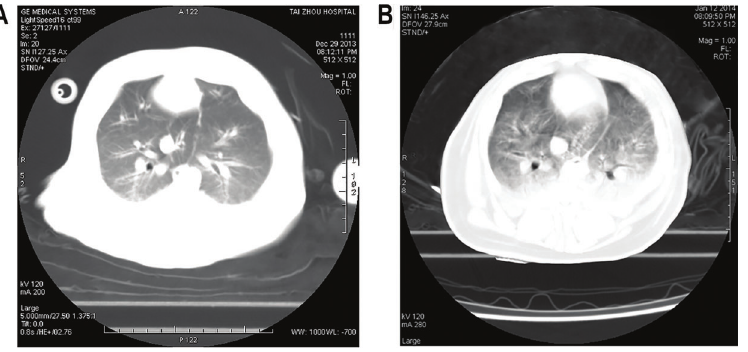
Figure 1. Pulmonary CT test of acute respiratory distress syndrome piglet model. A , Before modeling, lungs were normal; B , after modeling, lungs showed diffuse in fi l- trate and pulmonary atelectasis.